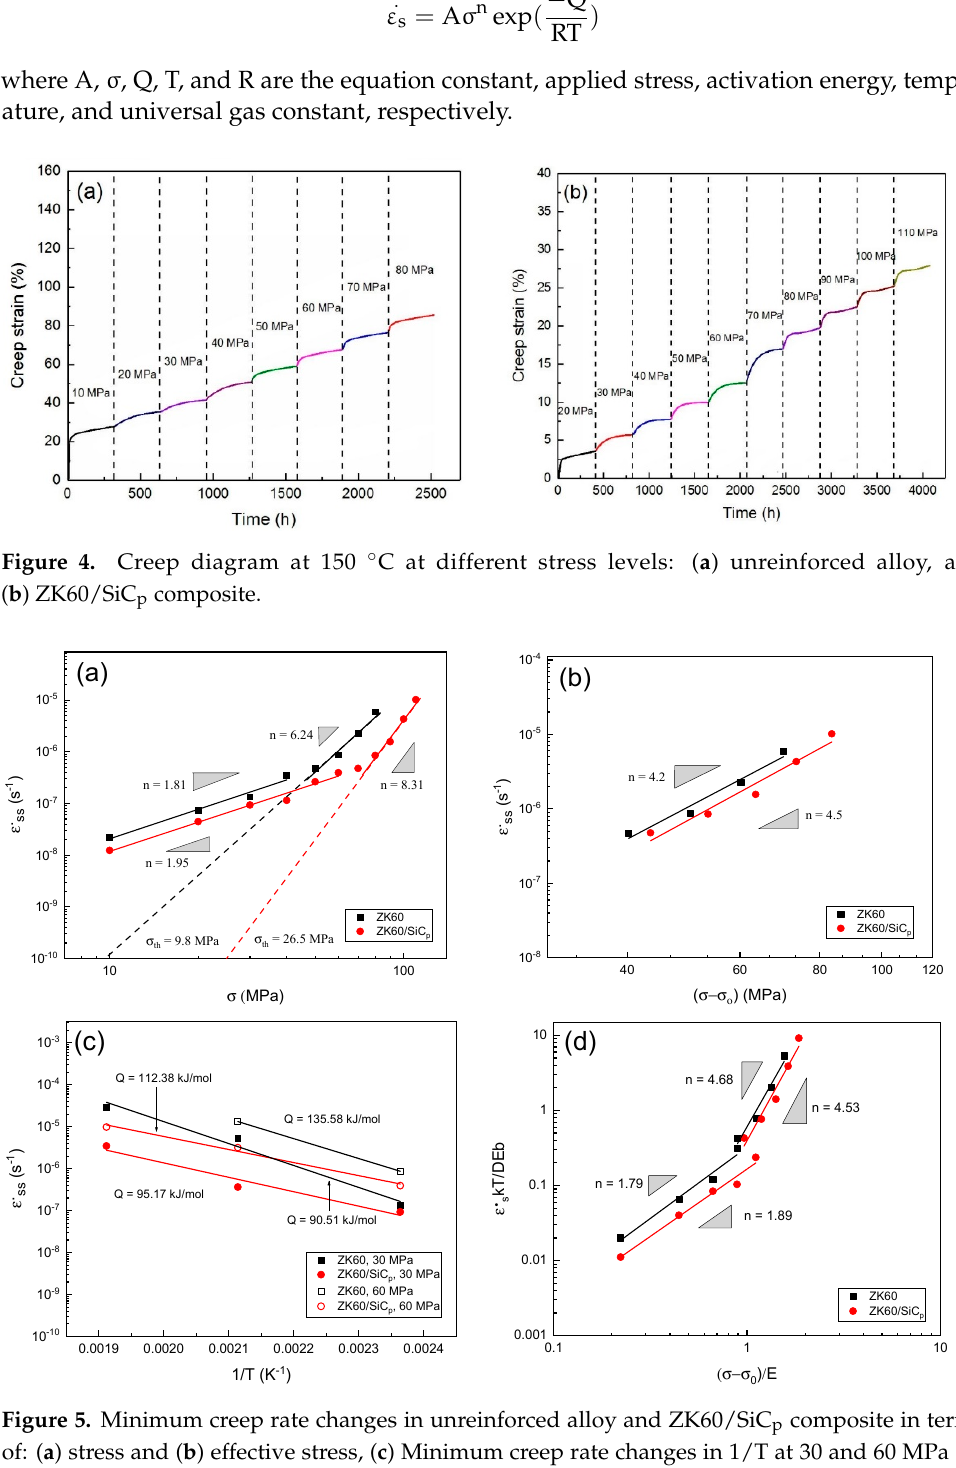
Figure 4. Creep diagram at 150 °C at different stress levels: ( a ) unreinforced alloy, and ( b ) ZK60/SiC p composite .